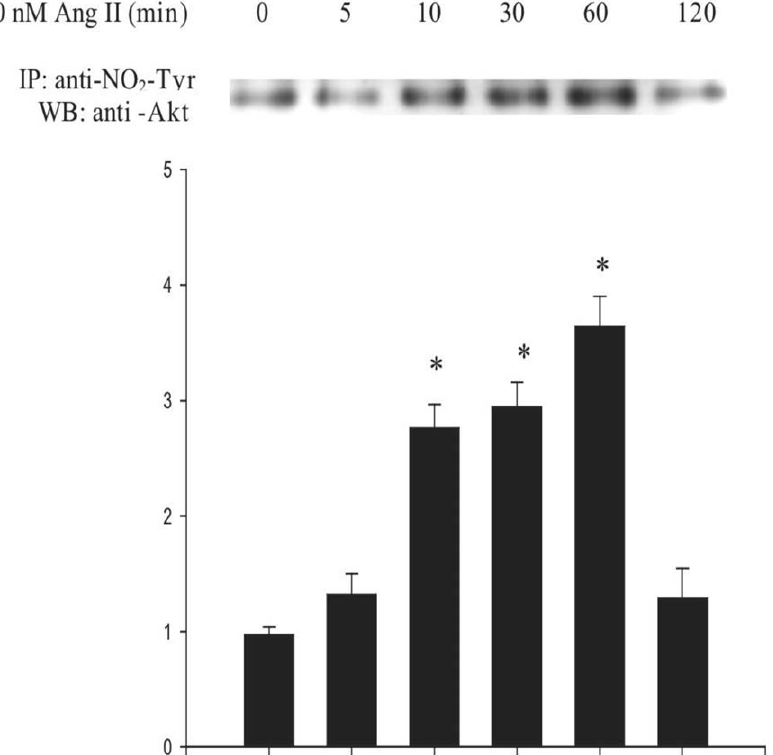
Figure 3. Kinetics of Ang II-mediated Akt nitration. L6 myotubes were exposed to Ang II (10 nM) for 0–120 min. Western blot of nitrated proteins from the soluble fractions were immunoprecipitated with anti-nitrotyrosine antibody and probed with anti-Akt antibody. Results are expressed as the fold increase over controls (means 6 s.d.) and the blot is representative of three independent experiments (* P , 0,05 vs. control).